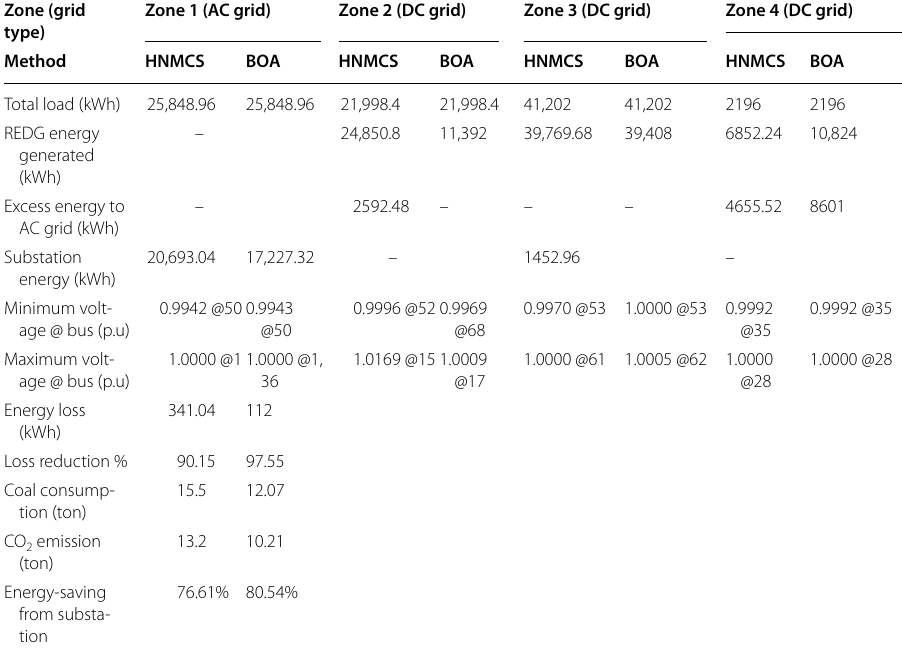
Table 7 Comparison of energy flow in 69-bus AC/DC hybrid distribution micro-grid under standalone mode of REDG